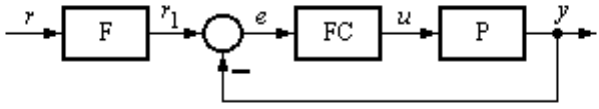
Figure 1. Structure of the fuzzy control system, yre −=